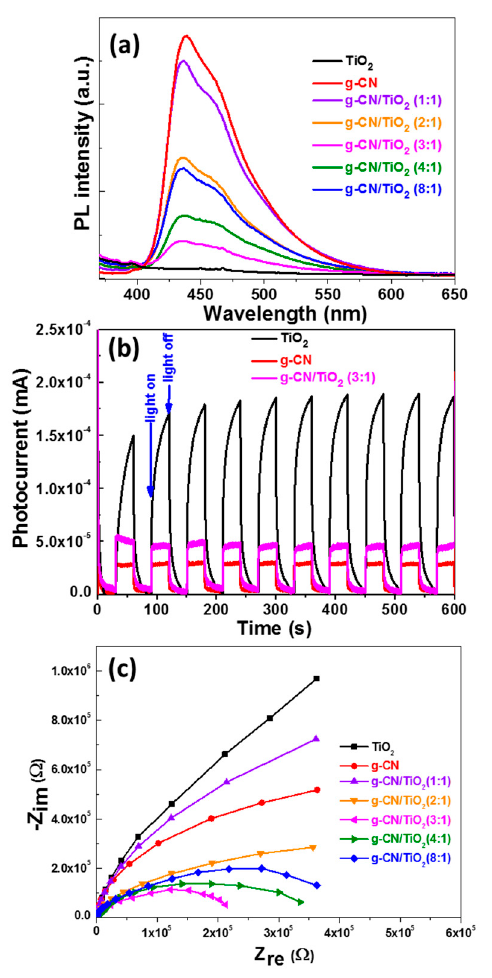
Figure 10. ( a ) Room temperature photoluminescence (PL) emission spectra of TiO 2 , g-CN, and g- CN/TiO 2 materials ( λ ex = 350 nm), ( b ) Photocurrent responses of TiO 2 , g-CN, and g-CN/TiO 2